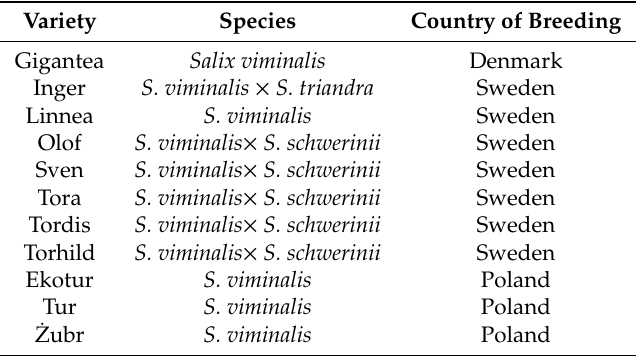
Table 1. Varieties of willow tested in the field experiment.